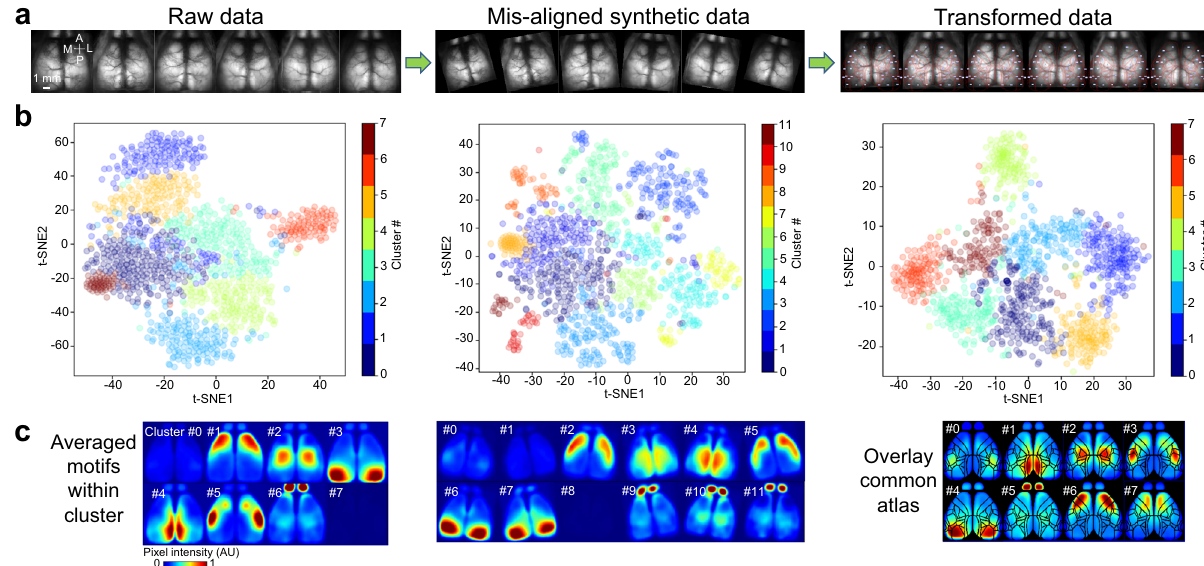
Fig. 6 Performance of brain-to-atlas transformation for clustering cortical activity motifs. a Raw brain images, synthetic brain images, and brain-to-atlas transformed brain images from 6 GCaMP6 mice. b Scatter plot of motif clusters. An unsupervised clustering algorithm (Phenograph) was used to classify the motifs ( n = 1194 motifs from 6 mice). Different colors in the t-SNE plot indicate different motif clusters. Left panel: scatter plot of motif clusters of 6 mice using raw data, silhouette score = 0.43. Middle panel: motif clusters of synthetic misaligned data, Silhouette Score = 0.39. Right panel: motif clusters of transformed data, silhouette score = 0.48. c Averaged motifs for each cluster of raw, synthetic mis-aligned, and transformed data. All the spatio- temporal motifs in each cluster were averaged, and the maximum temporal dynamics were projected onto one image. The pixel intensity scale is normalized, and the intensity value is arbitrary because responses are convolved with independently scaled temporal weightings to reconstruct the normalized DF/F fl